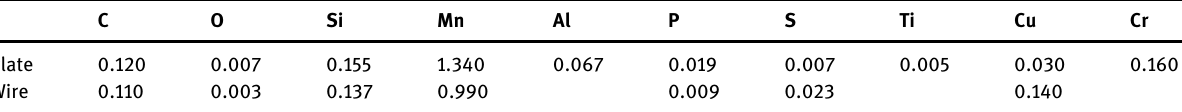
Table 1: Plate and wire compositions ( mass%